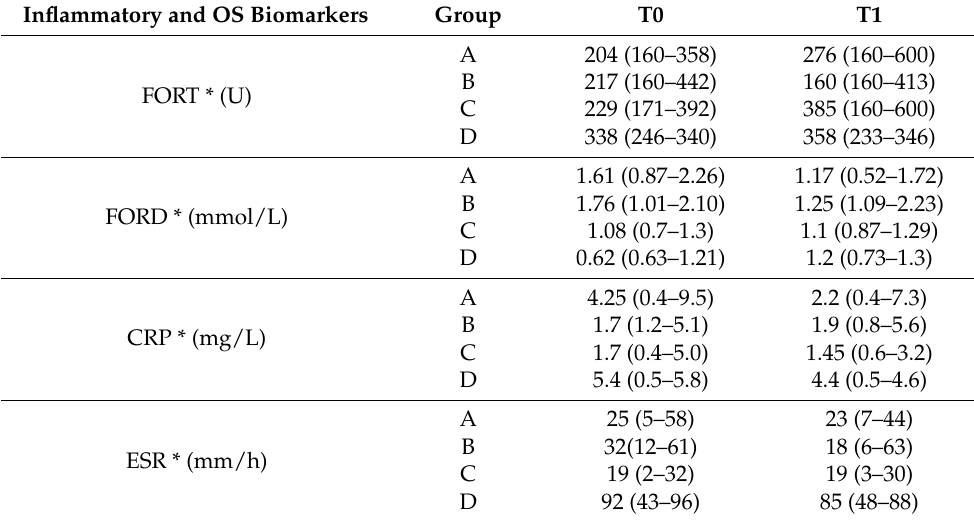
Table 5. Inflammatory and oxidative stress laboratory biomarkers of the study population divided according to treatment group. * This parameter is represented as median